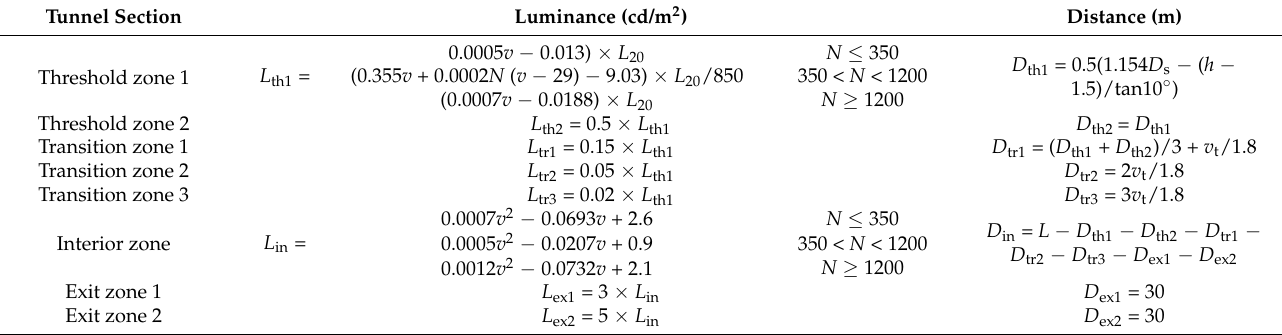
Table 5. Luminance and length of tunnel zones shown in Figure 5.